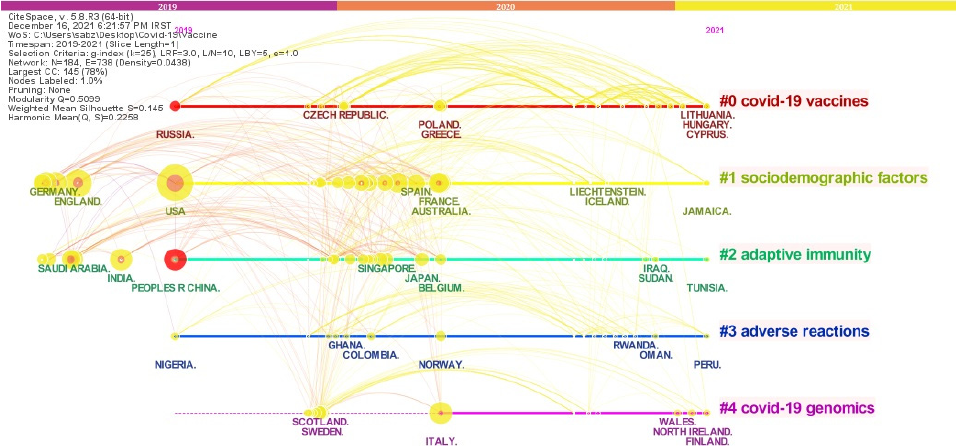
Figure 12. Timeline map of countries in COVID-19 vaccines research based on Authors keywords.